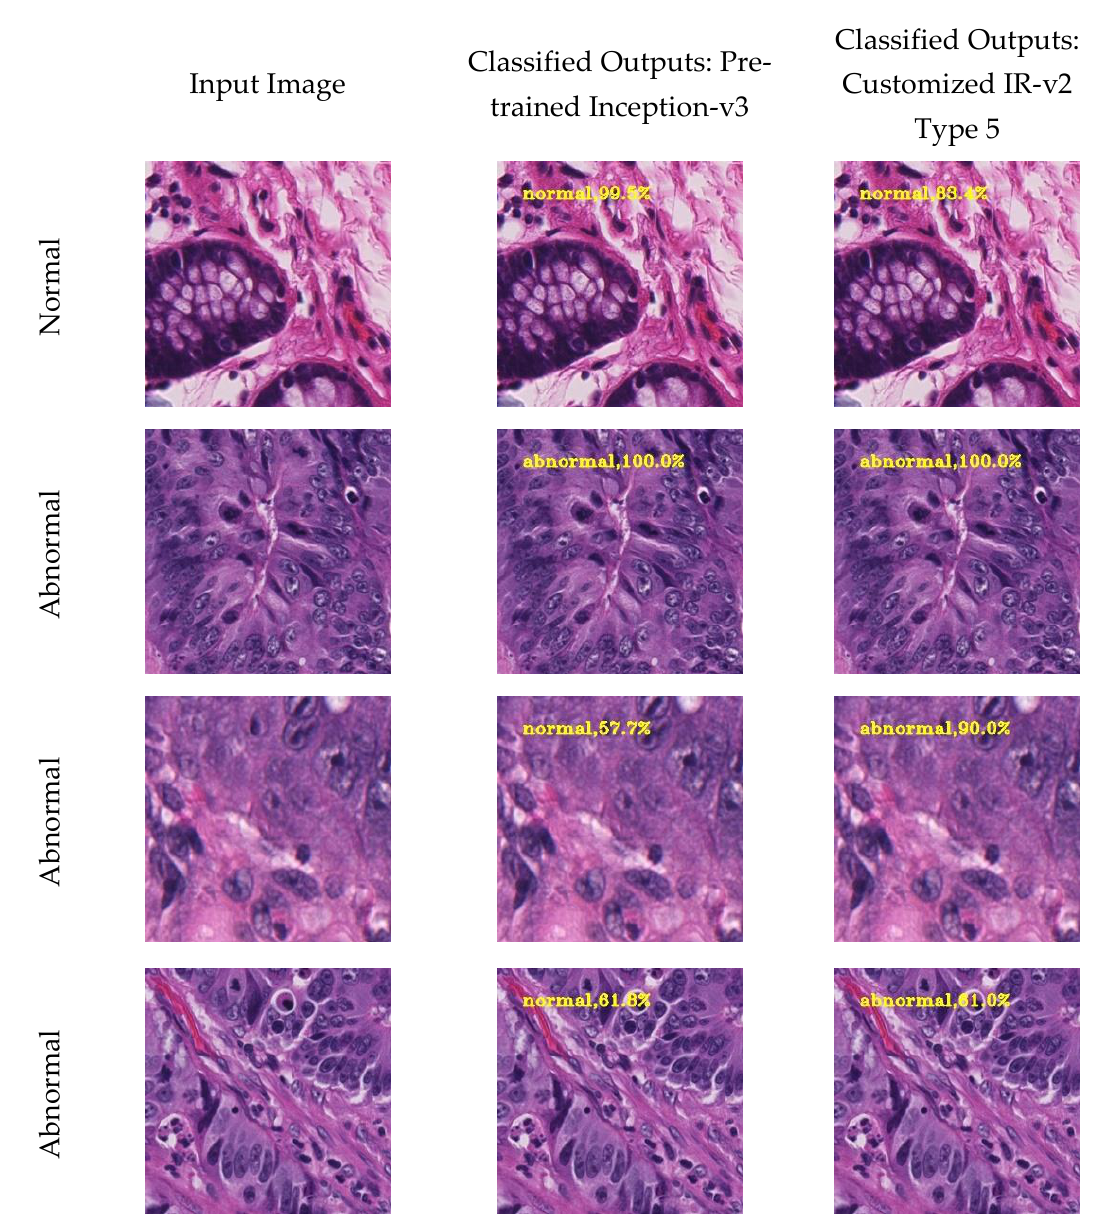
Figure 9. Classification results produced by the models with own dataset: column 1: input image; column 2: classified outputs from pretrained Inception-v3; and column 3: classified outputs from IR-v2 Type 5.